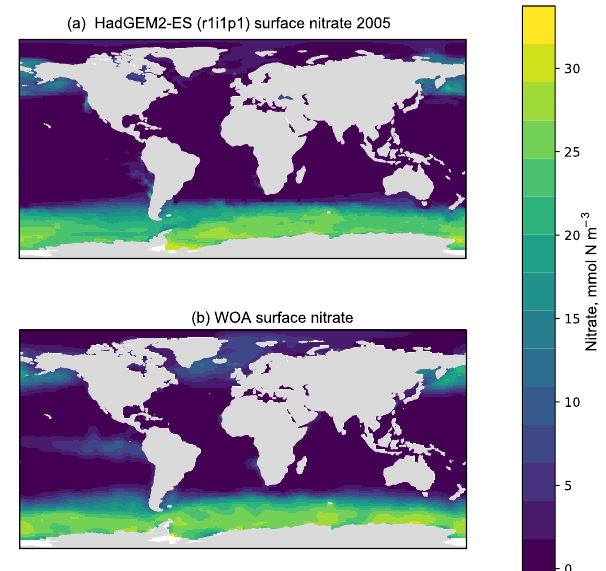
Figure 5. A plot produced by the time series package. The figure shows the spatial distribution of the model (a) and the observational dataset (b) . In this case, the model data are the global surface mean nitrate in HadGEM2-ES in the historical